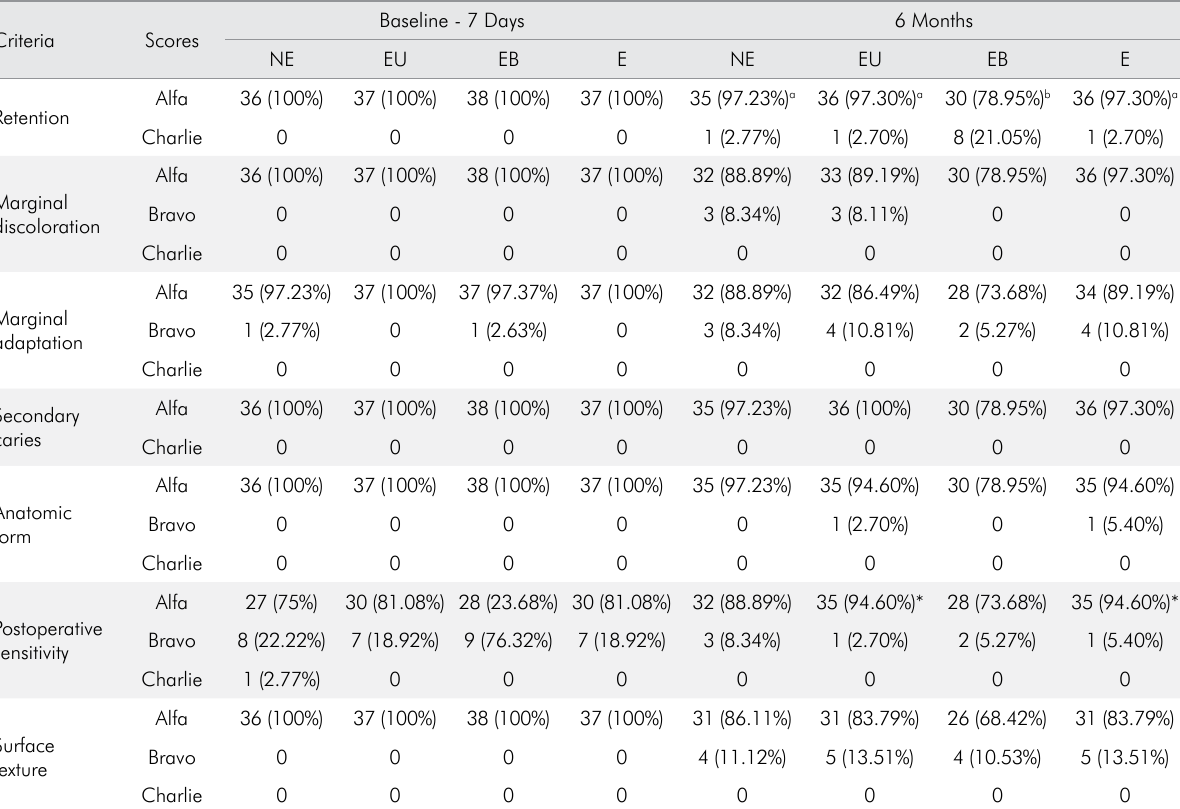
Table 2. Distribution of number of restorations and percentage (%) according to each evaluated criteria at 7 days and 6 months. Criteria